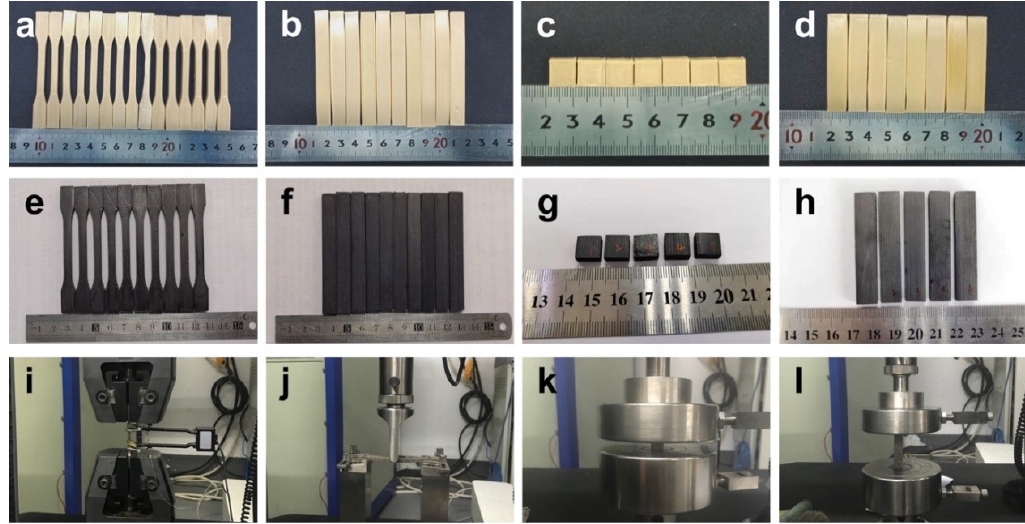
Figure 2. Pure PEEK and CFR‐PEEK samples for testing mechanical properties: ( a ) and ( e ) tensile samples of PEEK and CFR‐PEEK; ( b ) and ( f ) bending samples of PEEK and CFR‐PEEK; ( c ) and ( g